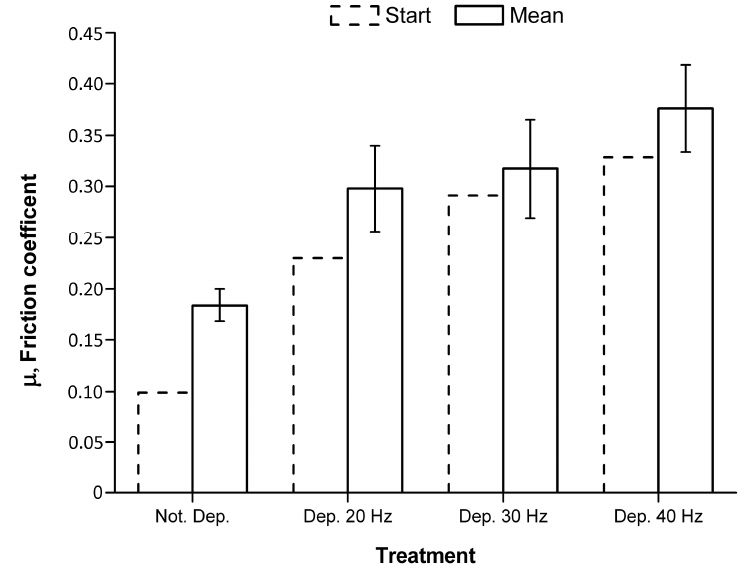
Figure 15. Friction coefficient analysis.